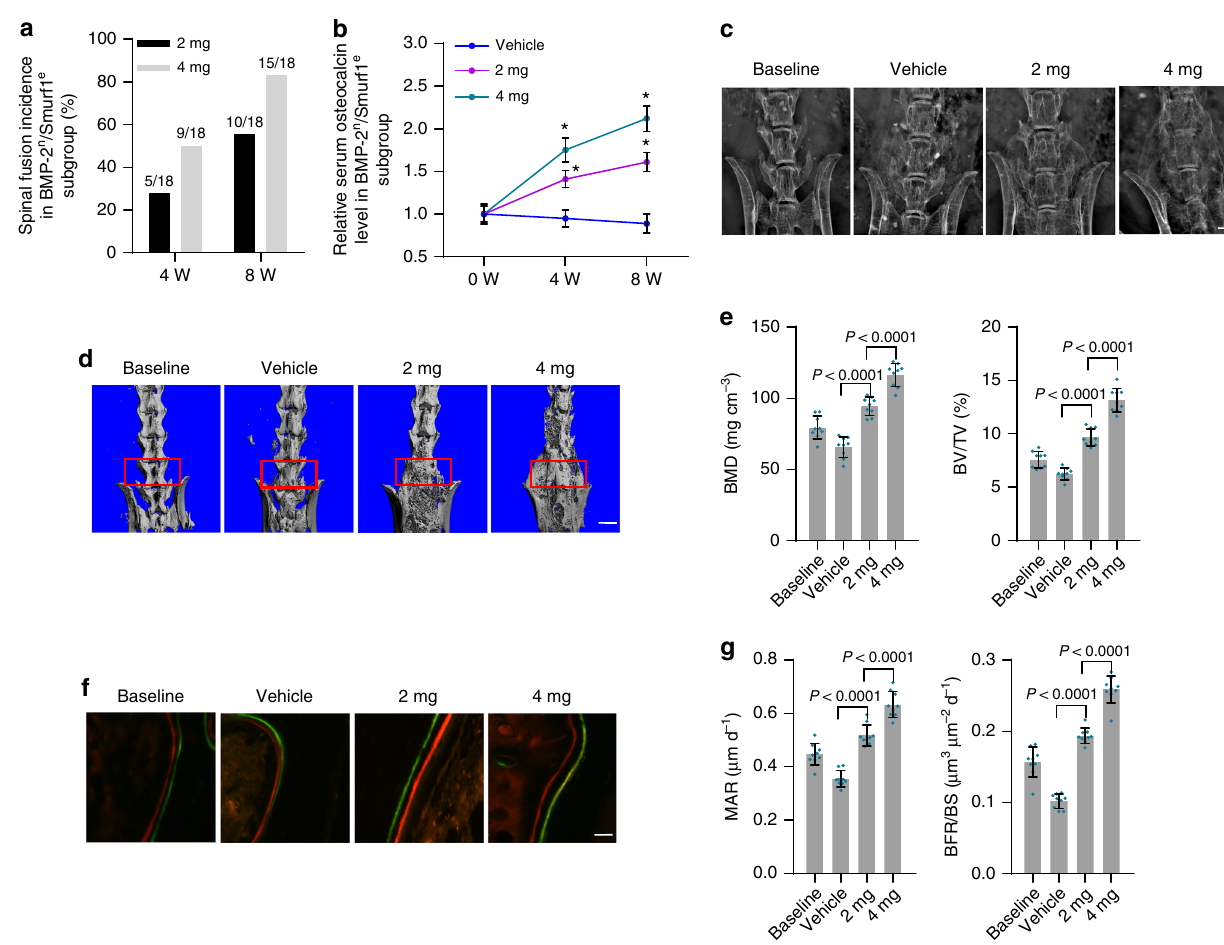
Fig. 5 In vivo effects of the chalcone derivative on local bone formation during spinal fusion in BMP-2 n /Smurf1 e mice. a Manual assessment of spinal fusion incidence during local administration of the chalcone derivative (2 or 4 mg per piece of ACS bilaterally) in BMP-2 n /Smurf1 e subgroup of 15-month-old osteoporotic mice (OVX at 6 months old) at 4 weeks (4 W) or 8 weeks (8 W). n = 18 per group. Fisher ’ s exact test was performed ( P = 0.016 and 0.001 for 2 mg and 4 mg versus vehicle at 4 W, respectively; P < 0.0001 for 2 mg or 4 mg versus vehicle at 8 W). b Relative serum osteocalcin level during local administration of the chalcone derivative or vehicle (DMSO) in BMP-2 n /Smurf1 e subgroup. The level of serum osteocalcin in BMP-2 n /Smurf1 e subgroup was normalized to the baseline before spinal fusion surgery. * P < 0.0001 for 2 mg versus vehicle or 4 mg versus 2 mg at 4 W and 8 W. c Radiographic analysis of spinal fusion in L4-L6 vertebrae by X-ray. Scale bars, 3.0 mm. d Representative images showing bone mass in spinal fusion sites (indicated by red rectangle) by microCT measurement. Scale bars, 2.5 mm. e microCT measurements for BMD and BV/TV in spinal fusion sites. f Representative images showing bone formation in spinal fusion sites assessed by xylenol (red) and calcein (green) labeling. Scale bars, 10 μ m. g Analysis of dynamic bone histomorphometric parameters (MAR and BFR/BS) in spinal fusion sites. n = 9 per group. Data are mean ± s.d. followed by one-way ANOVA with a post-